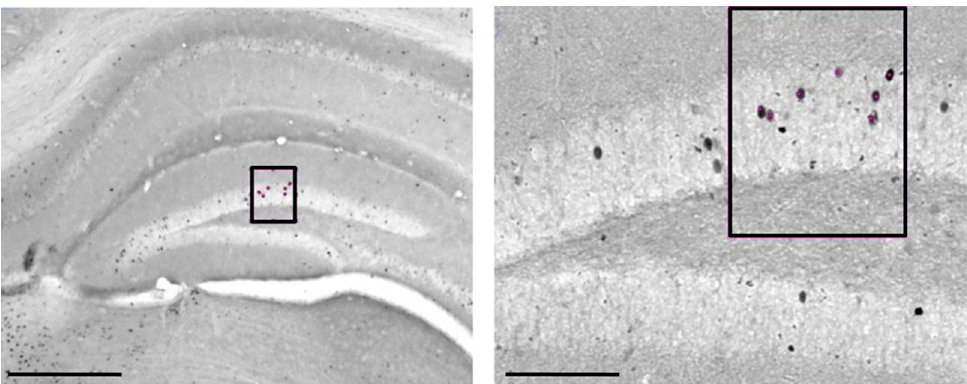
Figure 8. Representative photomicrographs of c-Fos+ cells (highlighted in the black boxes) in hippocampal CA1, CA3 and dentate gyrus (DG) of an animal treated with vehicle at lower (4×) (on the left, Scale bar: 1000 μ m) and higher (20×) (on the right, Scale Bar: 200 μ m) magnification.